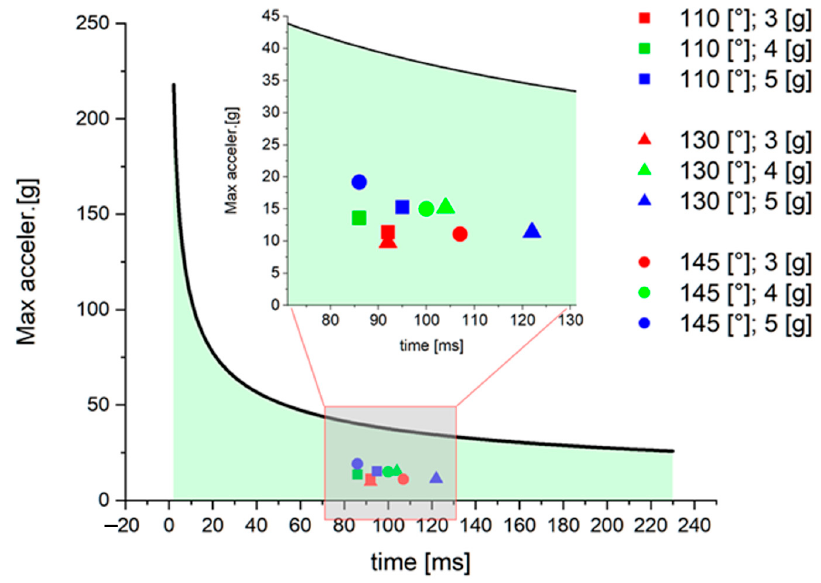
Figure 9. Maximal head acceleration on a Wayne State Tolerance Curve.